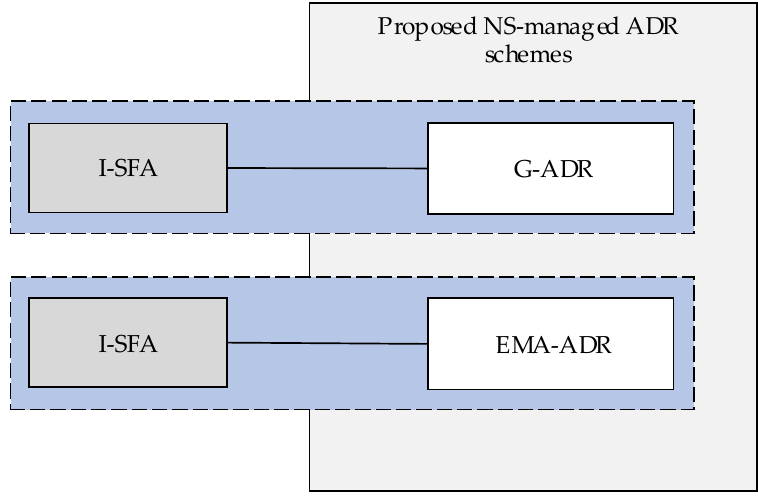
Figure 2. Overview of the proposed NS-managed ADR schemes.